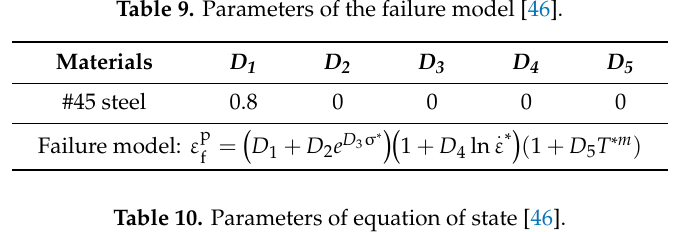
Table 10. Parameters of equation of state [46].